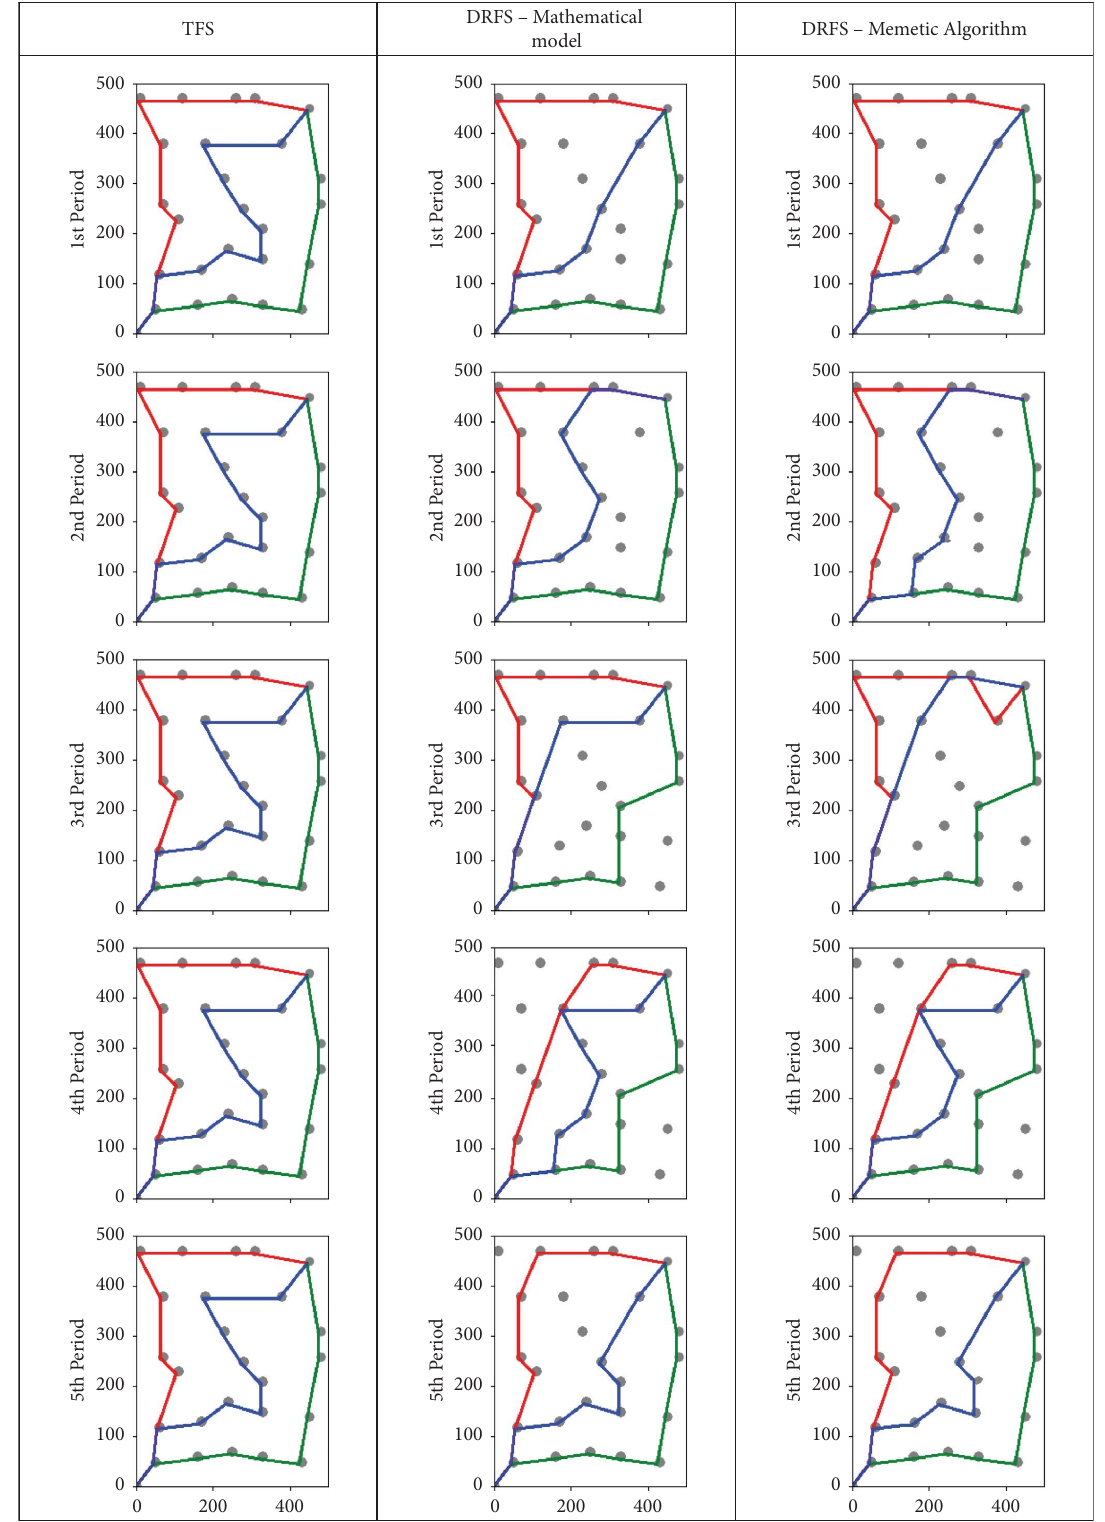
Figure 8: Routes for total operation in the TFS (1 st column), the optimal solution obtained with the mathematical model for the DRFS (2 nd column), and the solution obtained for the DRFS with the MA (3 rd column) for all the fve operation periods of one